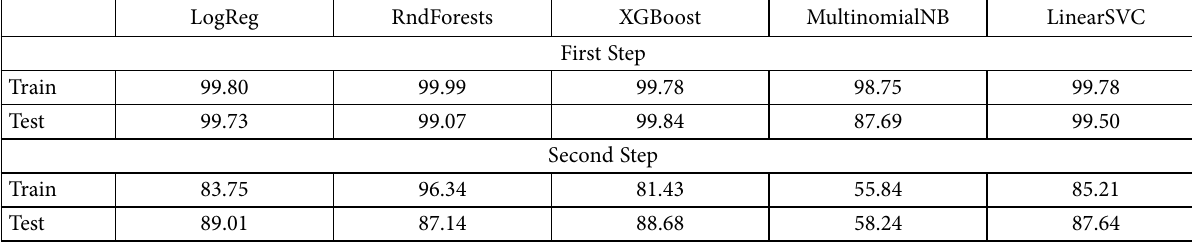
Table 6. Results of applying five techniques and their % of absolute and relative accuracy